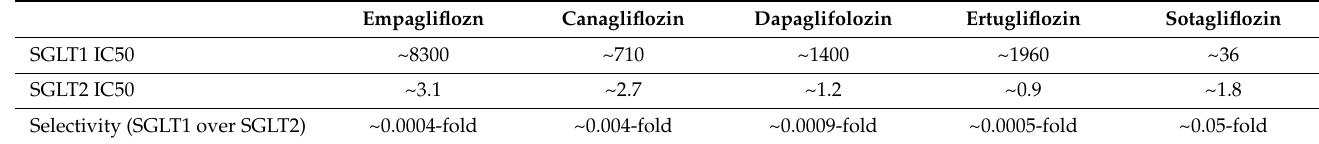
Table 2. Selectivity of sodium–glucose cotransporter 1/2 (SGLT1/2) inhibition.